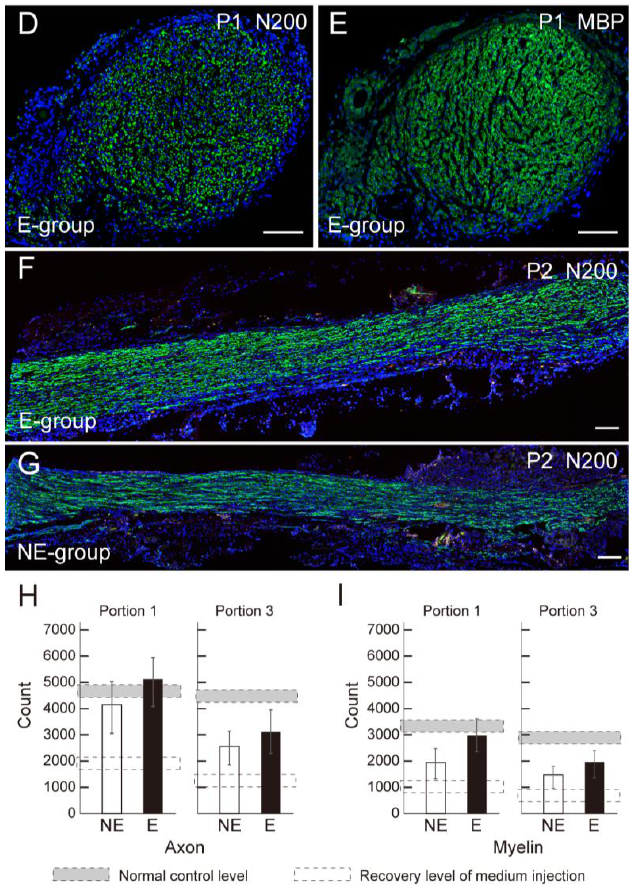
Figure 1. Extraction of histological sections and comparison of the number of axons and myelin in the conduit. ( A ) Histological sections were obtained from three portions; Portions 1 and 3 are cross-sections, and Portion 2 is a longitudinal section; ( B , C ) Typical engraftment of human Sk-34 cells stained with HNA (human nuclear antigen, red) in cross- ( B ) and longitudinal ( C ) sections; ( D , E ) Typical staining of axons ( D , N200, green), and typical staining of myelin ( E , MBP; myelin basic protein, green) E-group; ( F , G ) Similarly, typical staining of axons (green) in longitudinal sections (Portion 2) both in E-group ( F ) and NE-group ( G ); Axonal regeneration is apparent through the conduit in both groups. Blue staining is nuclear staining of 4′,6-diamidino-2-phenylindole (DAPI). P1 and P2 correspond to Portions 1 and 2, respectively. Bars in B-E = 100 μm; ( H ) Axon numerical recovery in Portions 1 and 3; ( I ) Myelin numerical recovery in Portions 1 and 3. The E group consistently showed greater recovery of axon and myelin in the conduit than the NE group. NE = non- exercise group, E = exercise group. Gray dotted square shows the mean number of axons in the same portion of a normal control sciatic nerve based on our pooled data. An open dotted square shows the